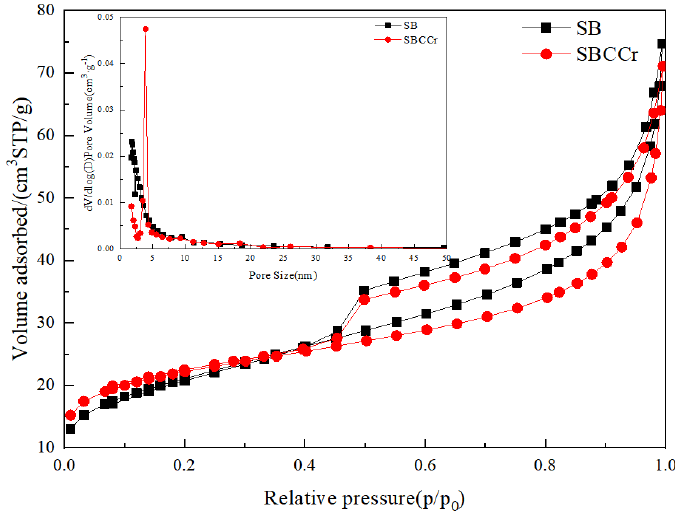
Figure 4. Adsorption/desorption isotherms and pore size distribution of SB and SBCCr.